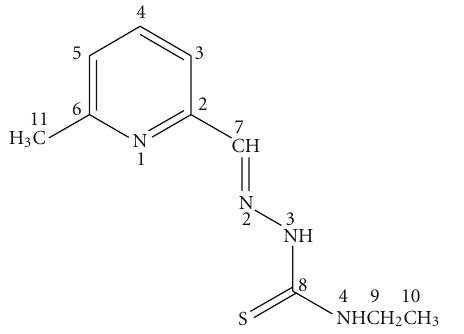
Figure 1: Structure of 6-methylpyridine-2-carbaldehyde-N(4)- ethylthiosemicarbazone (HmpETSC).